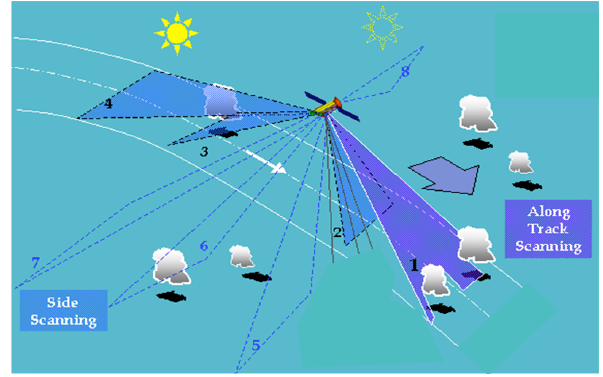
Fig. 11. Conceptual design of a 3-D Cloud Aerosol Interaction Mis- sion satellite (CLAIM-3D) specially designed to perform detailed measurements of aerosols particles and its influences on cloud mi- crophysical properties and on the onset of